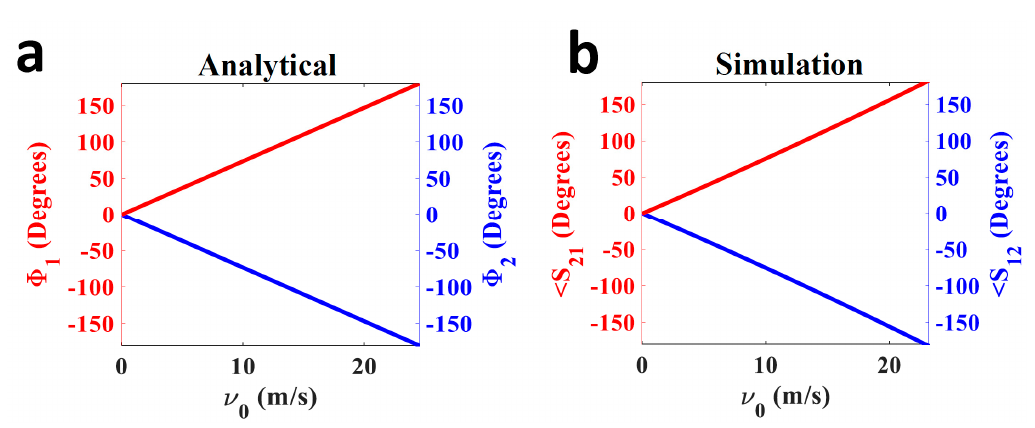
Figure 2. Scattering parameters of the proposed non-reciprocal acoustic phase shifters. ( a ) Employing Doppler spectral analysis, the variations of ϕ 1 and ϕ 2 versus the bias velocity ν 0 are calculated. When the fluid inside the waveguide is stationary, the forward and backward waves are subject to the same amount of phase shift ( ϕ 1 = ϕ 2 = 0). However, they start acquiring different amounts of transmission phase shifts ( ϕ 1 (cid:54) = ϕ 2 ) by increasing the bias velocity from zero. ( b ) Variation of the phase of the scattering parameters (S 12 and S 21 ) of the structure versus the bias velocity, calculated via full-wave numerical simulations. Numerical simulations validate our Doppler spectral analysis.